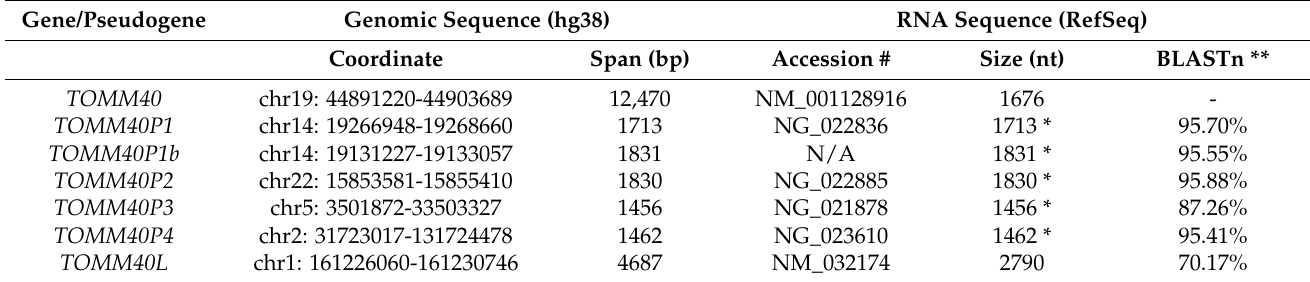
Table 2. Genomic locations and RNA transcripts of TOMM40 -related genes and pseudogenes.